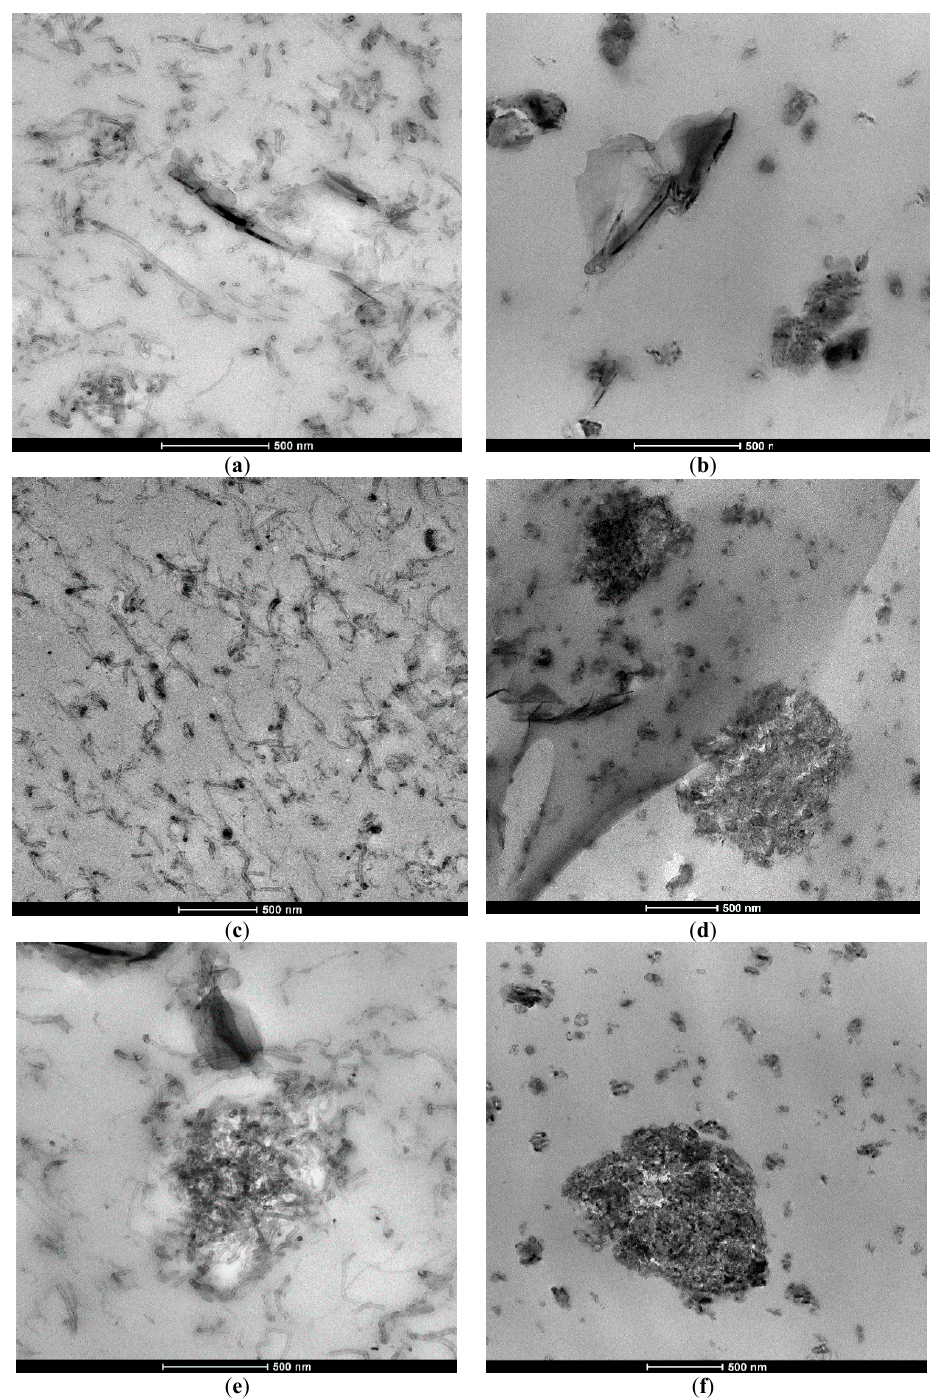
Figure 1. TEM micrographs of 6 wt % bifiller systems in different ratio of graphene nanoplatelets (GNPs) and multiwalled carbon nanotubes (MWCNTs) as prepared by melt mixing (M.M.) and solution blending (S.B.) techniques. ( a ) 1.5% GNP/4.5% MWCNT (M.M.); ( b ) 1.5% GNP/4.5% MWCNT (S.B.); ( c ) 3% GNP/3% MWCNT (M.M.); ( d ) 3% GNP/3% MWCNT (S.B.); ( e ) 4.5% GNP/1.5% MWCNT/poly(lactic) acid (PLA) (M.M.); ( f ) 4.5% GNP/1.5% MWCNT/PLA